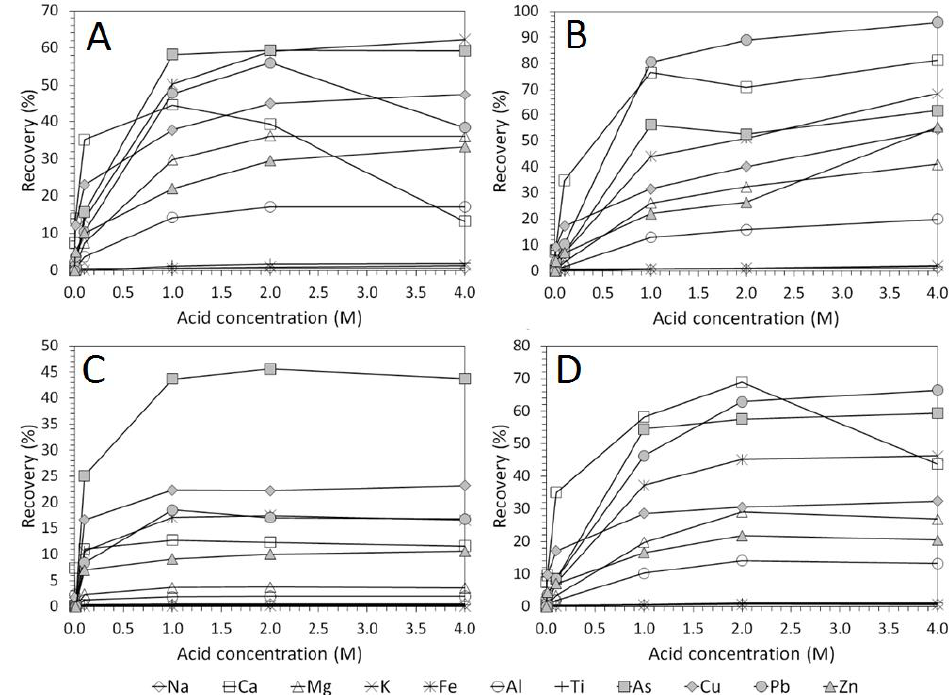
Figure 5. Metal recovery as a function of acid concentration after 48 h for each acid type: H 2 SO 4 ( A ), HCl ( B ), C 6 H 8 O 7 ( C ) and CH 3 SO 3 H ( D ) A solid – liquid ratio of 0.1 and lixiviant volume of 200 mL were used for each experiment.